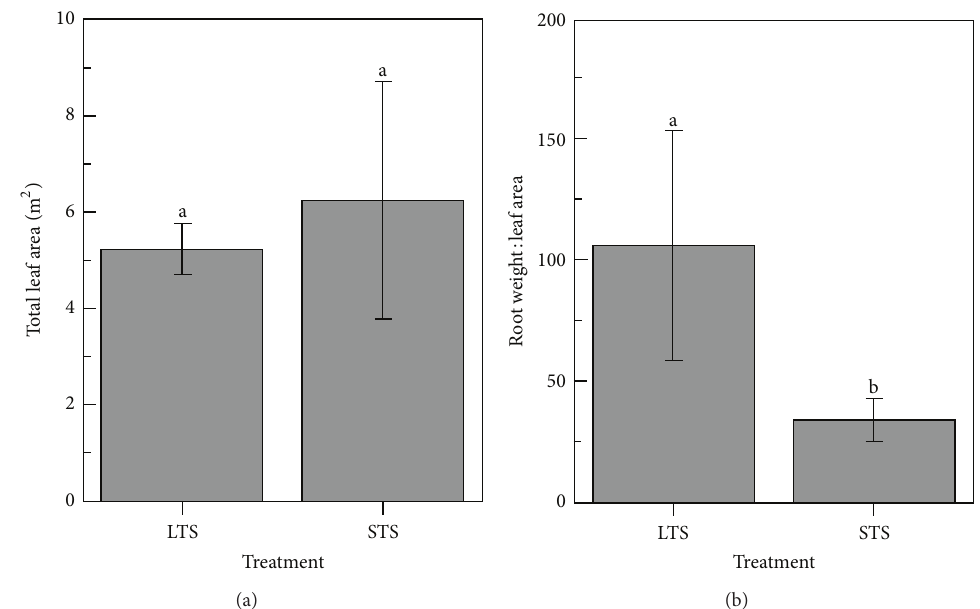
Figure 9: Mean and standard deviation of the (a) total leaf area and (b) root weight:leaf area ratio at 5, 20, and 40 cm depth. ∗ Non parametric analysis Mann-Whitney 𝑈 -Test. ∗ Different letters indicate significant difference ( 𝑝 < 0.05 ).